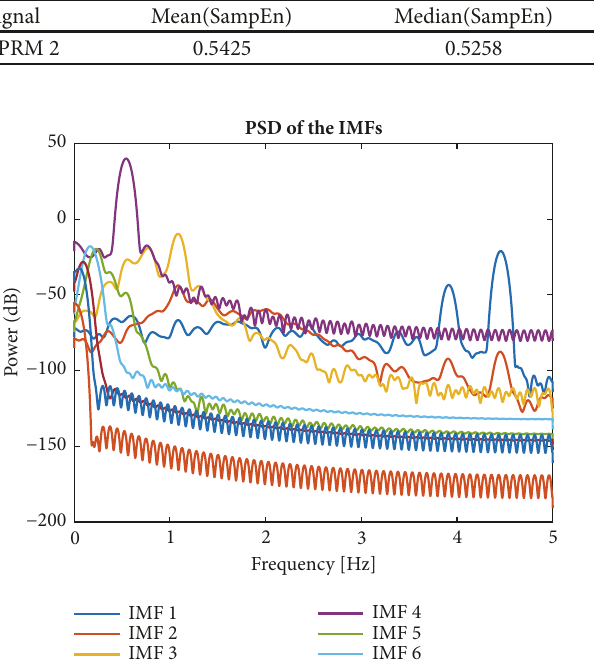
Figure12:PSDofthefirst6extractedIMFsintheanalyzedsegment. The PSD of the IMF 4 is highly concentrated around 0.5 Hz.